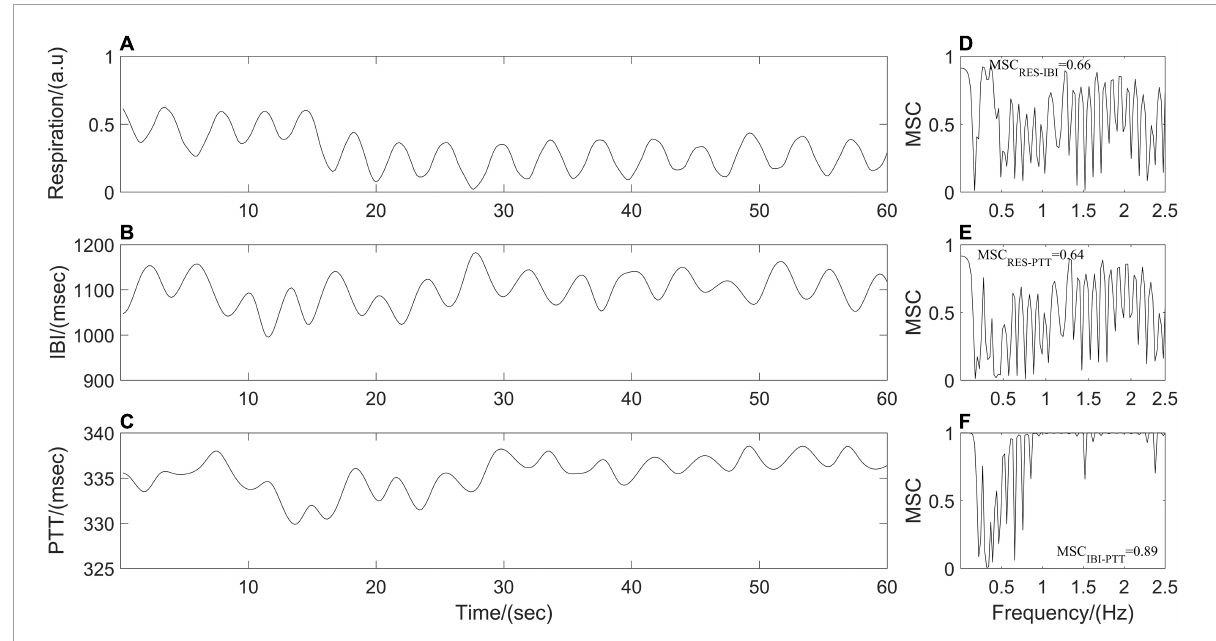
FIGURE2 (A–C) Resampled respiration, interbeat interval (IBI), and pulse transit time (PTT) time series from one participant. Panels (D–F) represent cardiorespiratory, respiratory-cardiovascular, and cardiovascular magnitude squared coherence (MSC), respectively.